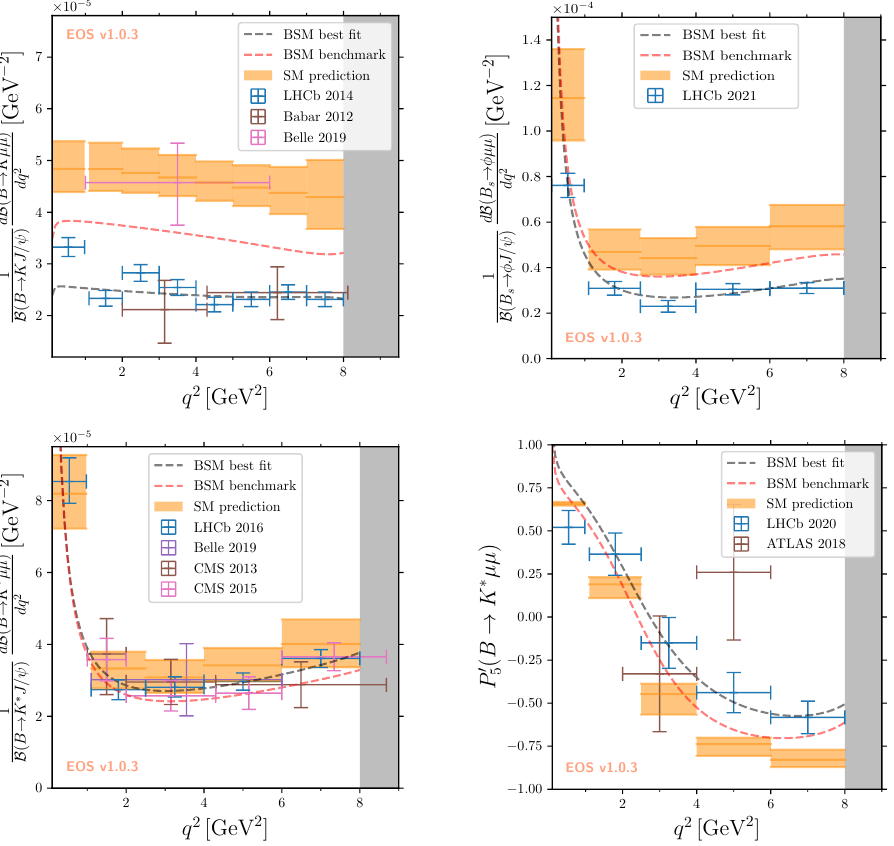
Figure 4 . Updated SM predictions for the normalized differential branching ratios and the opti- mized angular observable P 0 , which we overlay with two BSM scenarios. The scenario labeled “BSM 5 best fit” corresponds to the process-specific BSM best-fit point of the likelihoods of figure 5. “BSM benchmark” is obtained by setting C BSM = − C BSM = − 0 . 5 and adapting all hadronic parameters. 9 10 The small uncertainty in the first bin of P 0 compared to the literature is due to a smaller soft gluon 5 contribution